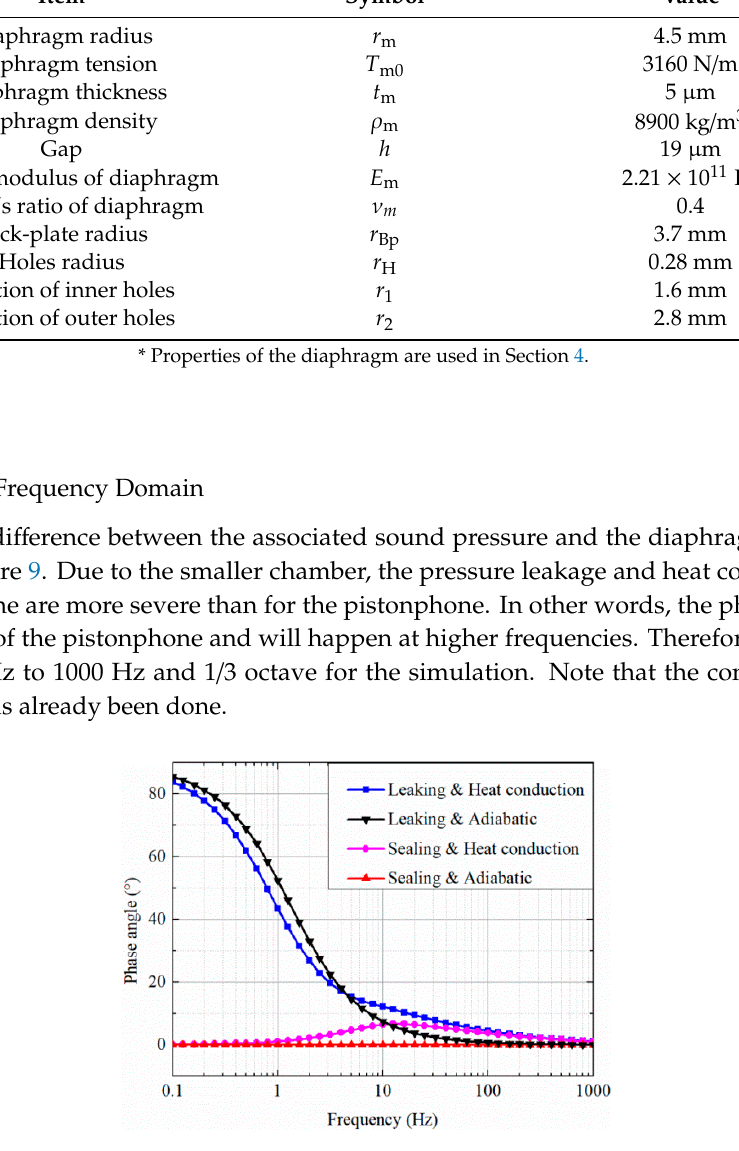
Figure 9. Phase di ff erence between the associated sound pressure and the diaphragm deformation of Figure 9. Phase difference between the associated sound pressure and the diaphragm deformation of the the microphone.